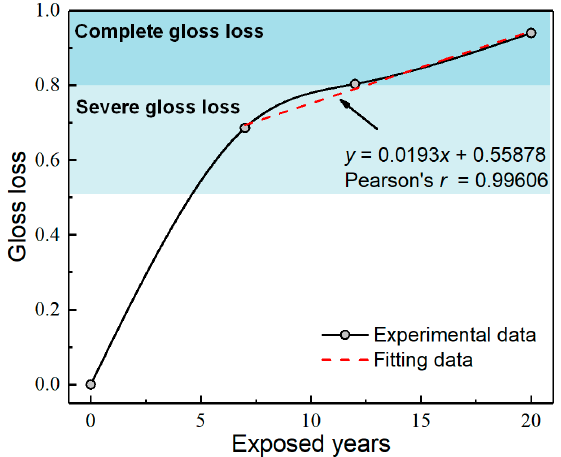
Figure 4. Gloss loss of the epoxy primer-coated specimens subjected to different durations of ex- posure.